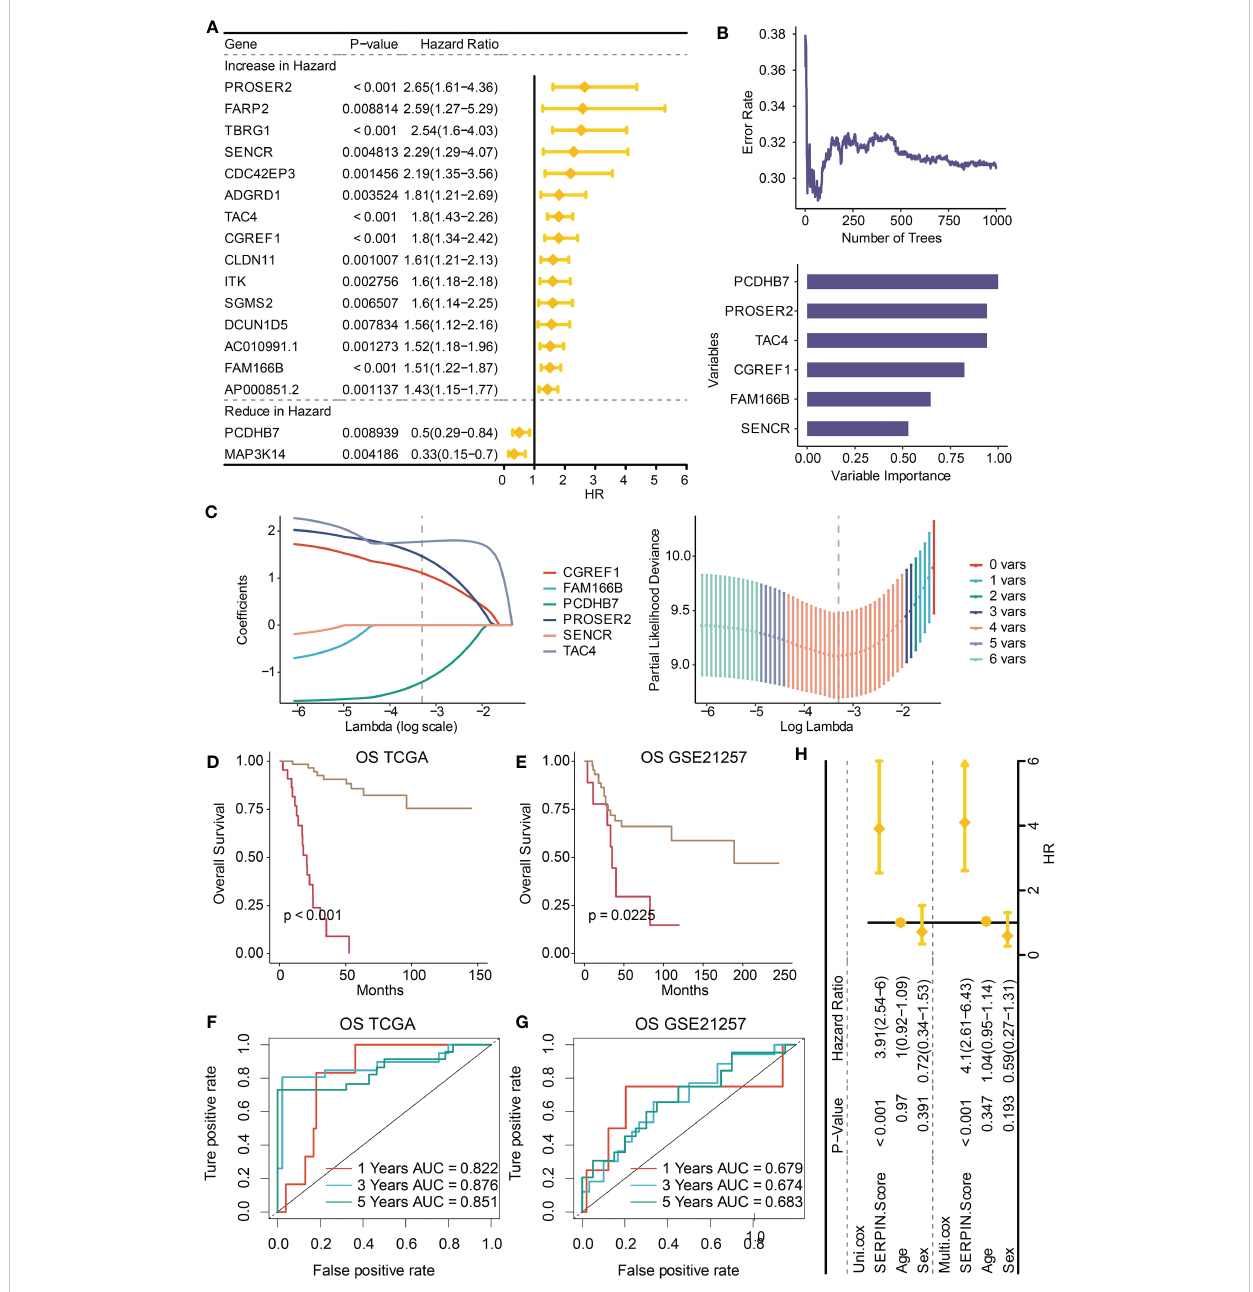
FIGURE 6 Construction of the SERPINH1-related score. (A) Univariate Cox regression analysis on the prognostic DEGs. (B) Machine learning Random Survival Forest for dimension reduction. (C) Machine learning LASSO for dimension reduction and constructing the SERPINH1-related score. (D) Survival curves of the two SERPINH1-related score-strati fi ed groups in the TCGA dataset. (E) Survival curves of the two SERPINH1-related score-strati fi ed groups in the GSE21257 dataset. (F) The 1-year, 3-year, and 5-year ROC regarding the SERPINH1-related score in the TCGA dataset. (G) The 1-year, 3-year, and 5-year ROC regarding the SERPINH1-related score in the GSE21257 dataset. (H) Univariate and multivariate Cox regression analysis on the clinical